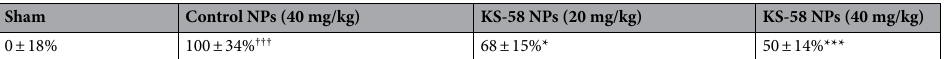
Table 2. PANC-1 tumor growth rate in vivo. Growth rate (%) was calculated based on the pancreas weight of the Sham group as 0% and the Control NPs group as 100% and expressed as the mean ± SD (n = 8, * p <